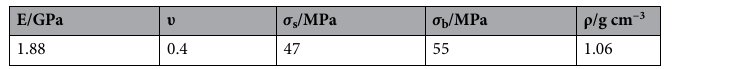
Table 1. Performance indicators of thermoplastic materials.